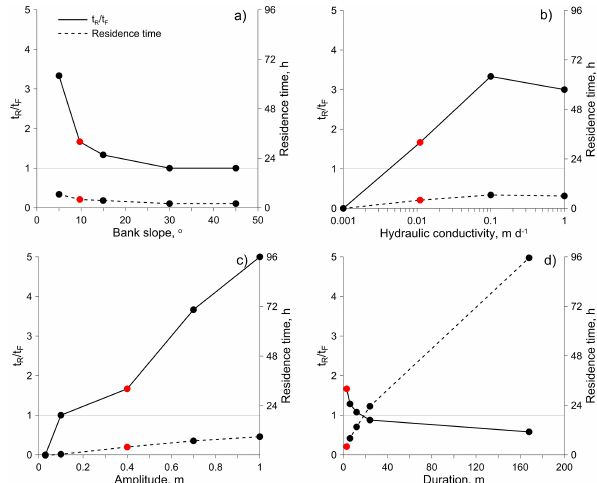
Figure 8. Return/fill time ratio ( t R / t F ) and residence time for differ- ent bank slope (a) , hydraulic conductivity (b) , wave amplitude (c) and duration (d) scenarios, with the reference case (red) and insets of the input wave